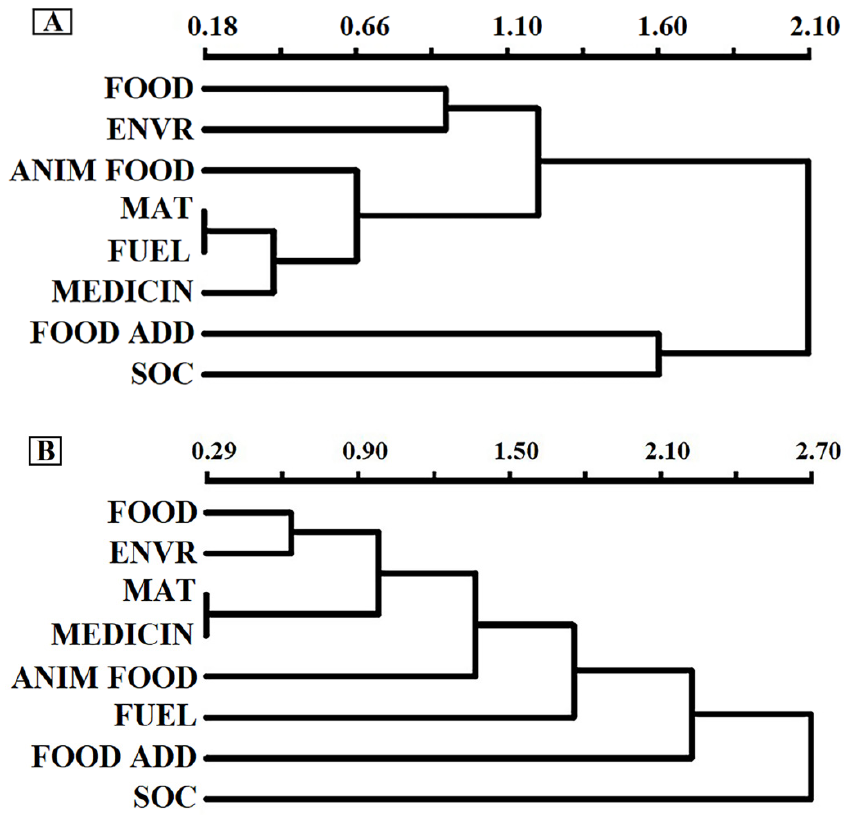
Figure 4. Two dendrograms from two-way cluster analyses. ( A ) Caesalpinioideae and eight use categories, correlation coefficient (r = 0.76391). ( B ) Papilionoideae and eight use categories, correlation coefficient (r = 0.88120). Each dendrogram is a graphical representation of its main matrix. The x -axis values are the measure of similarity or distance at which clusters join, re-ordered according to the order in produced. For use category abbreviations, see the caption of Figure